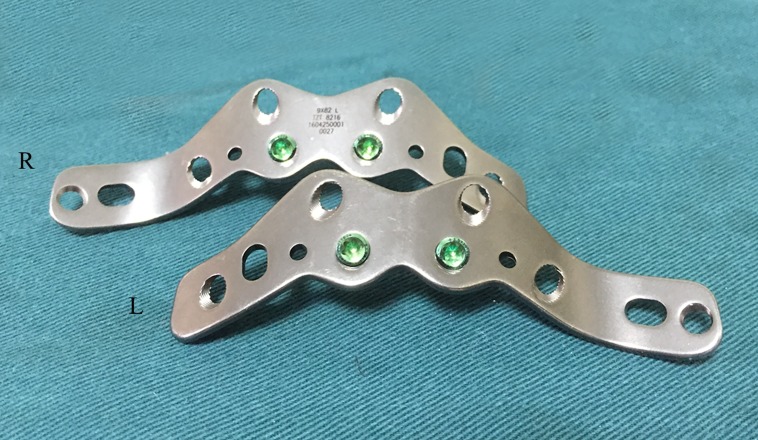
The W-shaped acetabular angular plate.R, right; L, left.